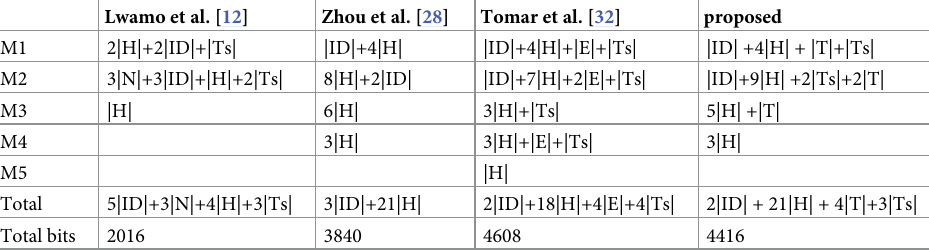
Table 6. Comparison of the computational cost between the proposed scheme and other schemes. Lwamo et al. [12]